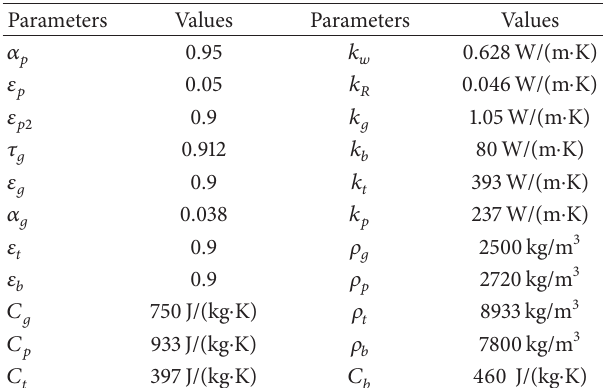
Figure 5: Differential grid partition of the absorber plate. Table 1: Thermal properties of the materials in the